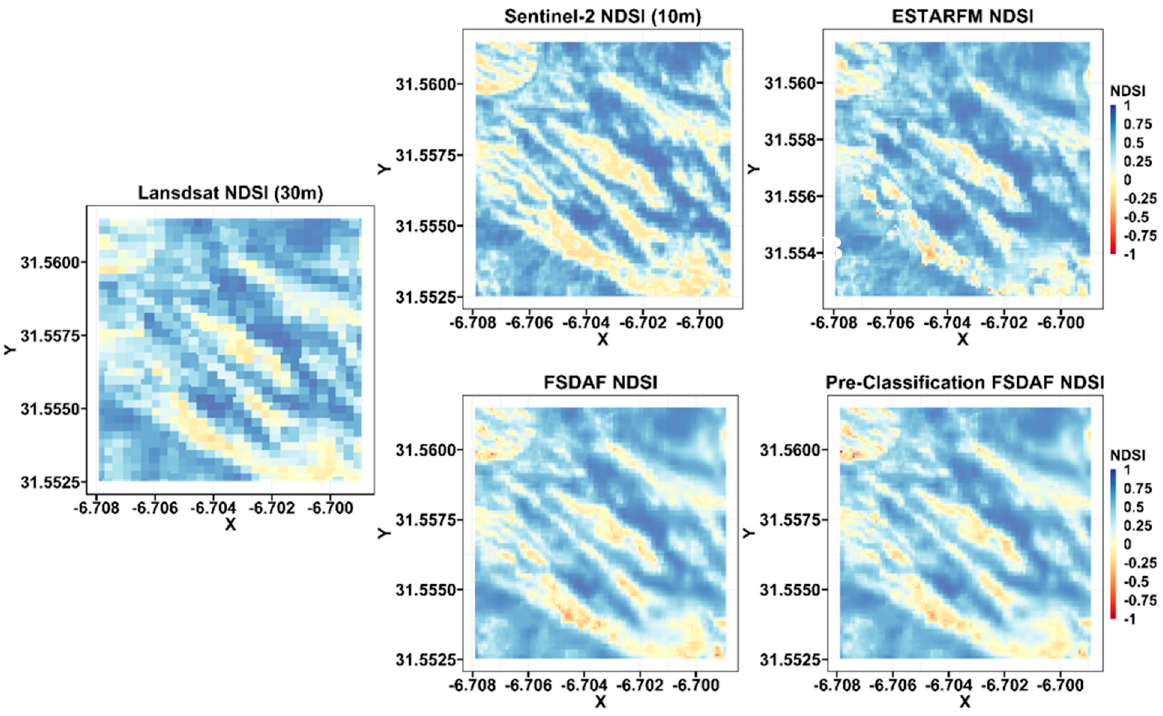
Figure 9. Visual comparisons of the real NDSI S2 image at 10 m resolution on 4 April 2016, and the NDSI L8 image at 30 m resolution, with its generated images using the ESTARFM, the FSDAF, and the pre − classification FSDAF models in subarea B for the Study Area.